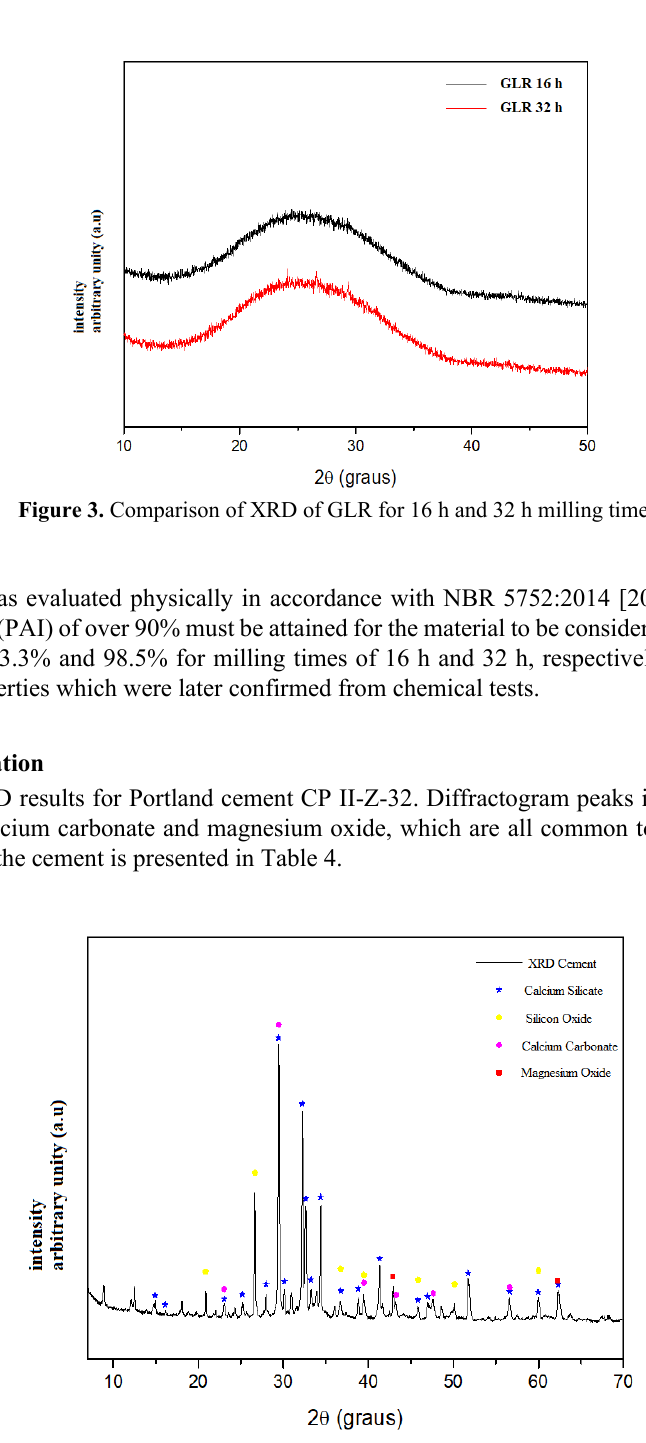
Figure 4. XRD of Portland cement